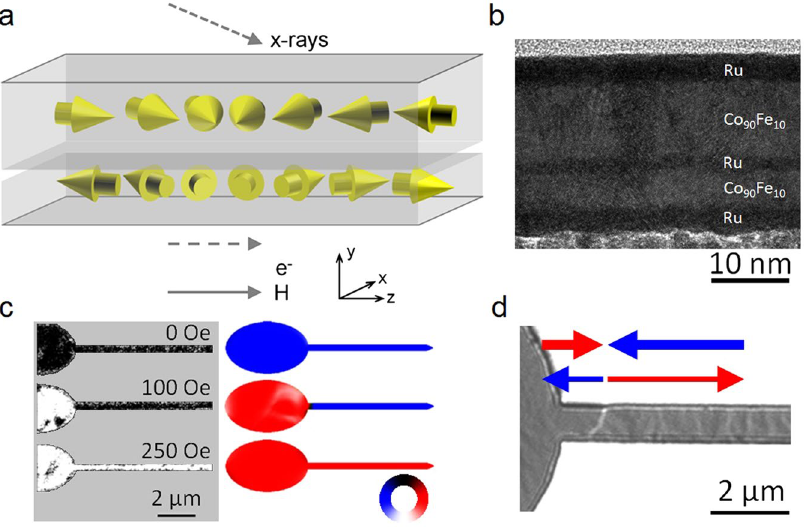
Figure 1. Domain walls in synthetic ferrimagnet nanostructures. ( a ) Diagram of SyF track indicating the directions of magnetisation, x-ray beam in the PEEM, electron flow (e − ) during magnetotransport, applied field ( H ) and defined coordinate system. ( b ) High-resolution TEM cross-section of SyF thin film. The layers are t 1 = 13.3 nm and t 2 = 6.6 nm thick separated by a 0.7 nm thick Ru spacer layer. ( c ) XMCD-PEEM images and micromagnetic simulations of SyF structure with 400 nm wide track, showing reversal of ellipse and track in the thicker Co 90 Fe 10 layer. XMCD-PEEM images are taken at remanence after application of a field pulse, with contrast sraing only from the upper, thicker layer. The color wheel indicates the magnetisation directions in the same layer in the micromagnetic simulations. ( d ) LTEM image of injected DW in SyF track with 800 nm width. The measured DW width is ~100 nm. The red and blue arrows indicate the inferred direction of magnetisation in the two